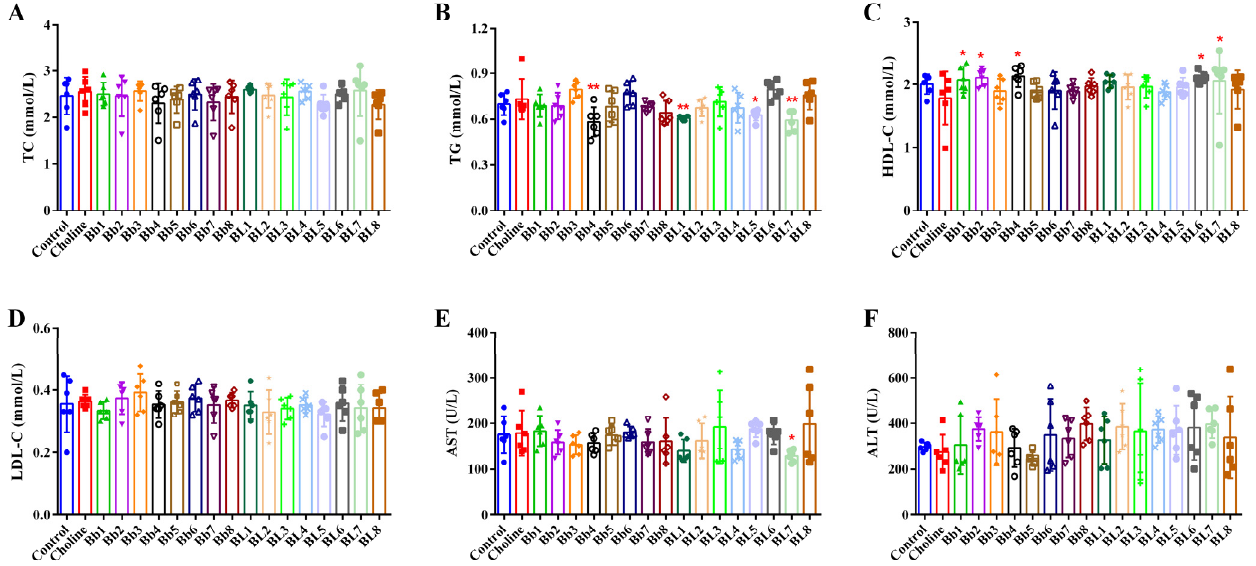
Figure 3. Plasma biochemical parameters: ( A ) total cholesterol level, ( B ) triglyceride level, ( C ) high- density lipoprotein-cholesterol level, ( D ) low-density lipoprotein-cholesterol level, ( E ) aspartate aminotransferase level, ( F ) alanine aminotransferase level. Values are mean ± SD; six mice per group. * p < 0.05, ** p < 0.01 versus the choline group.